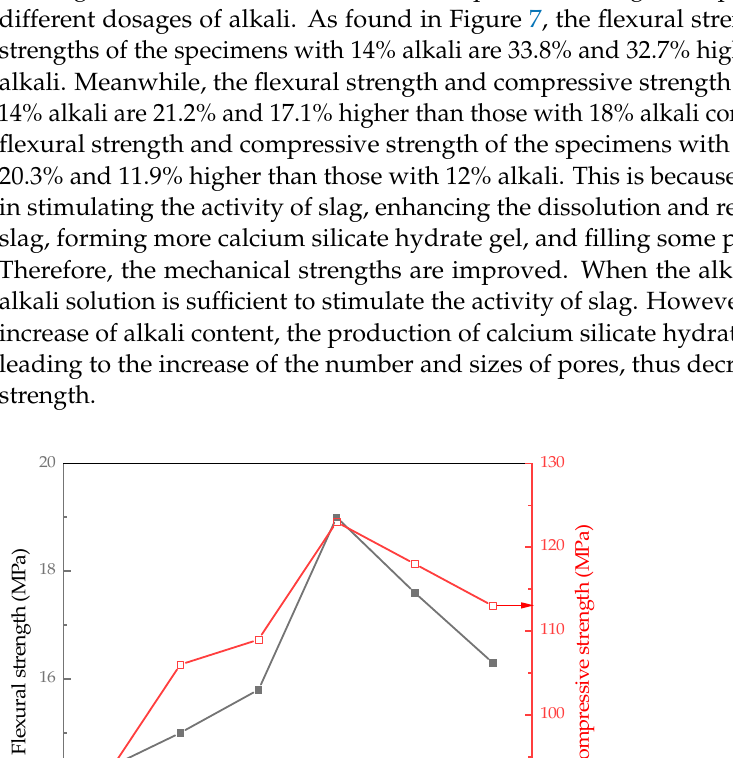
Figure 6. Mechanical strengths of alkali-activated BFS with different curing age and modulus.